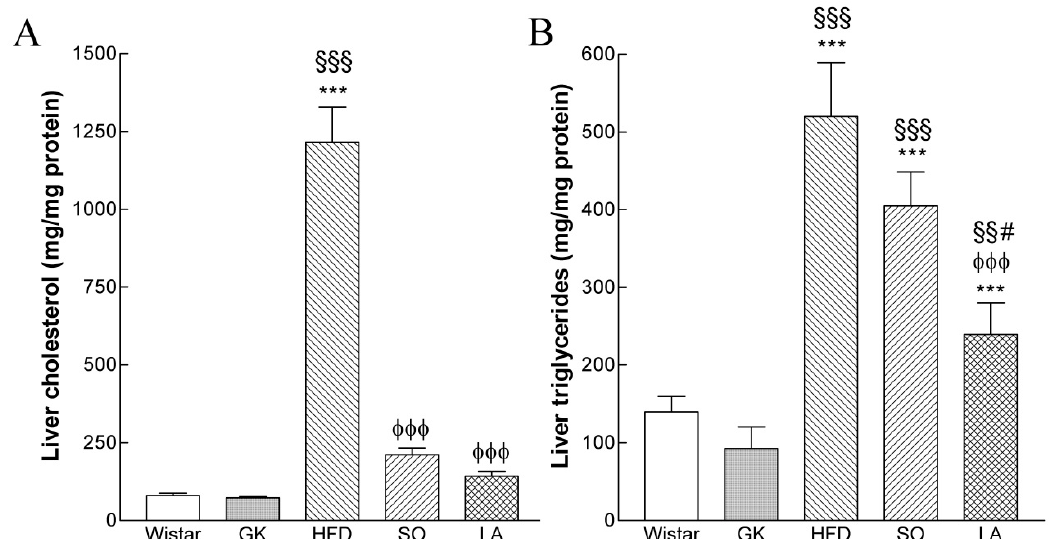
Figure 2. Effects of α -lipoic acid ( α -LA) on hepatic cholesterol ( A ) and triglycerides ( B ) levels in Wistar, Goto-kakizaki (GK) rats control and GK fed a high fat diet (HFD) with or without vehicle (soybean oil, SO) or α -LA. Data are expressed as mean ± SEM (n = 7 animals per group). *** p < 0.001 vs. Wistar group, §§ p < 0.01, §§§ p < 0.001 vs. GK group, φφφ p < 0.001 vs. GKHFD group, # p < 0.05 vs. GK SO group.